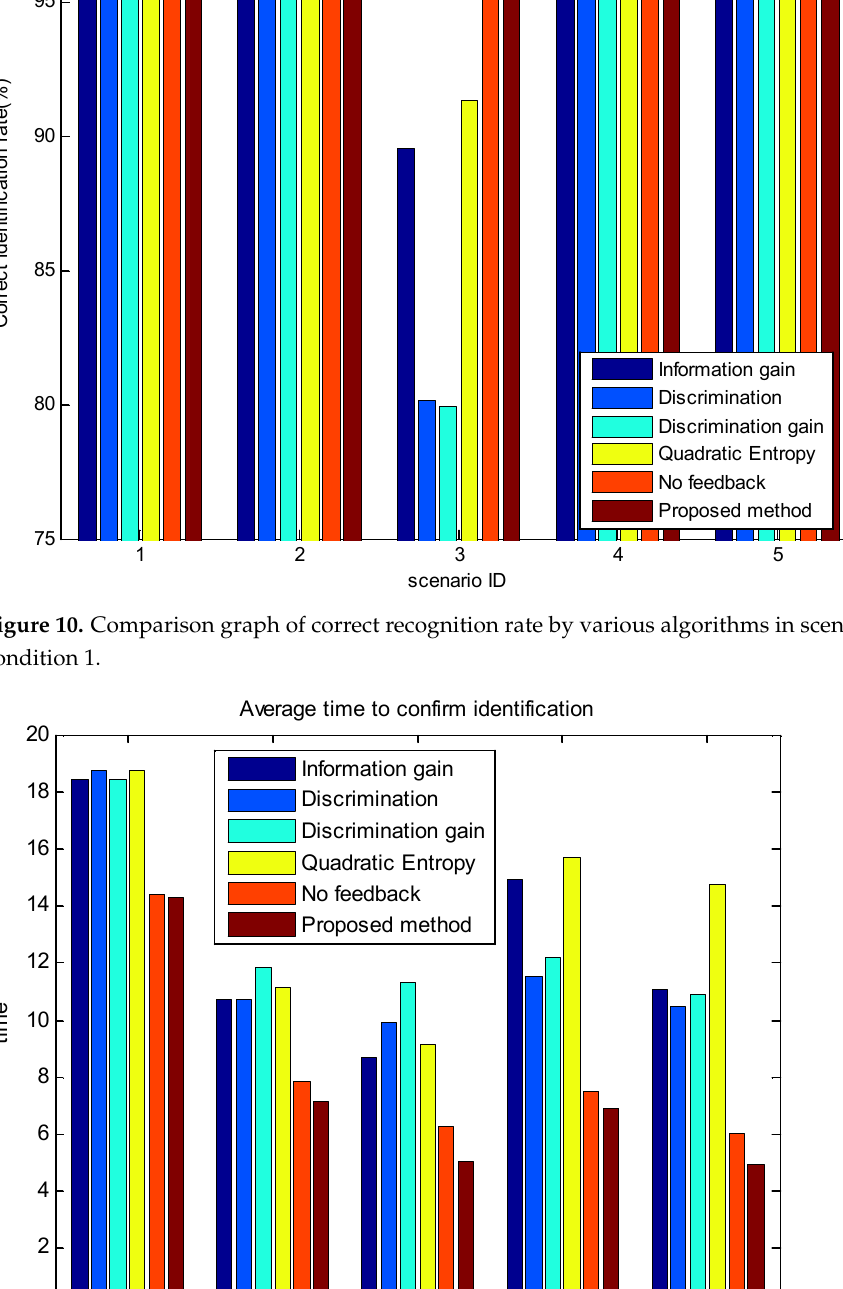
Figure 11. Comparison chart of average confirmation recognition time by various algorithms under condition 1.